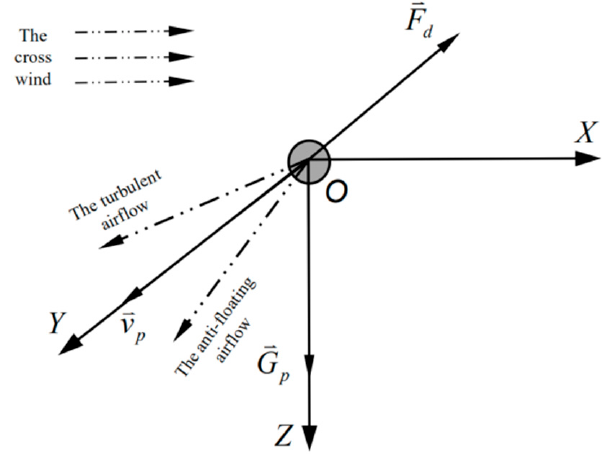
Figure 3. Forces diagram of a